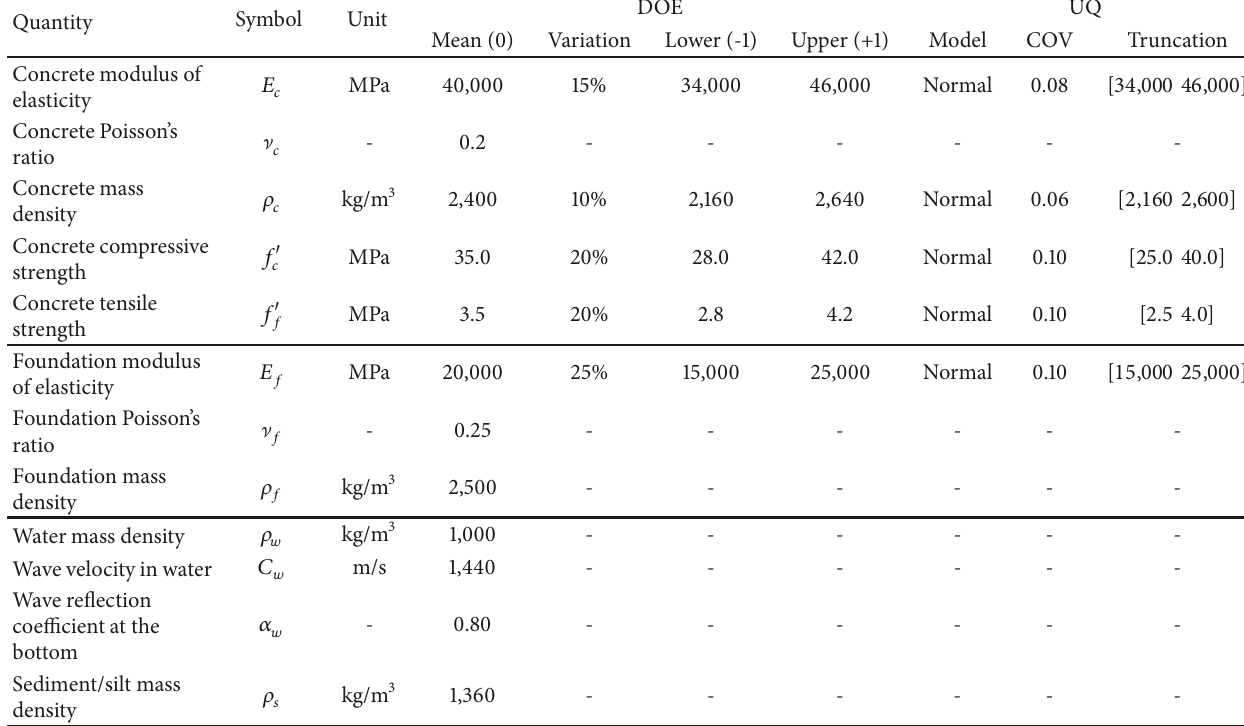
Table 1: Material properties for the finite element model.